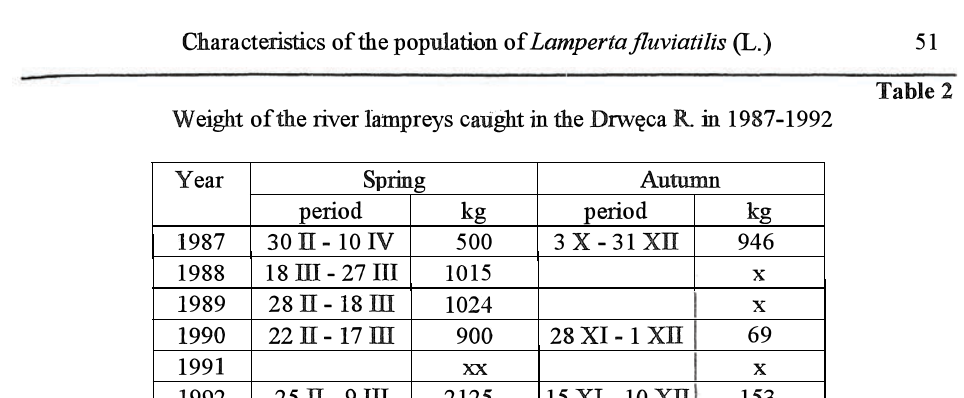
Sex ratio of the river lamprey from the Polish rivers during the upstream